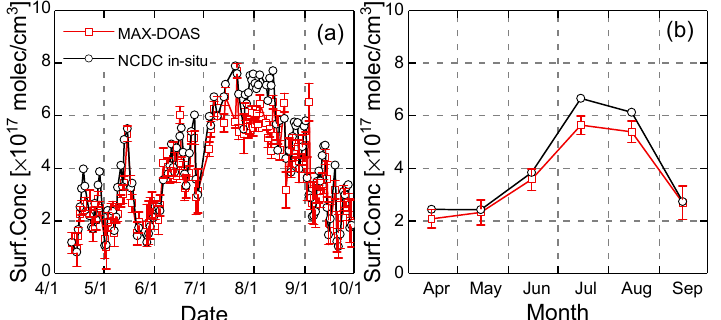
Figure 7. Daily ( a ) and monthly ( b ) averaged time series of water vapor surface concentrations derived from MAX-DOAS and NCDC.